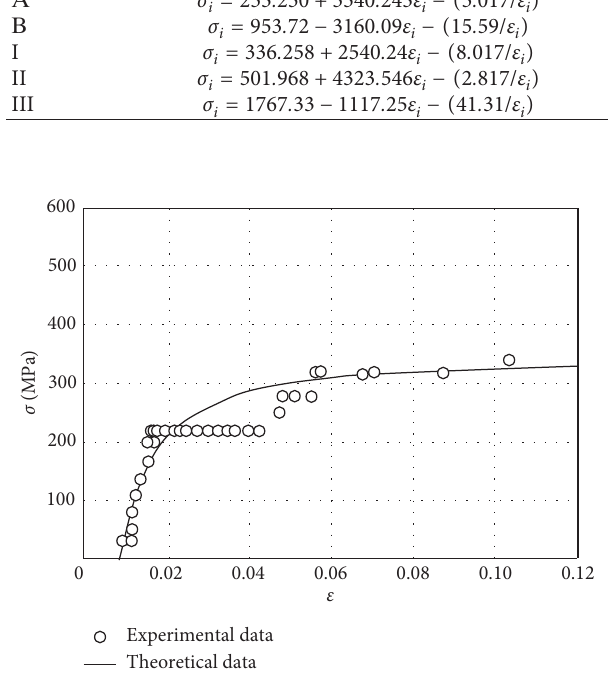
Figure 10: The dependence between the average value of micro- plastic deformation and the applied tensile stress in the deposited samples of steel 530H40 after annealing (group